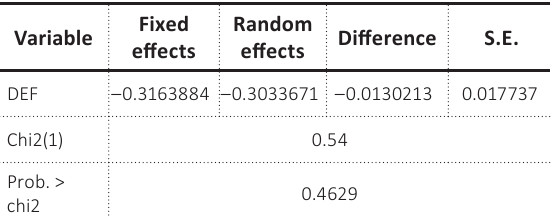
Source: Own construction.